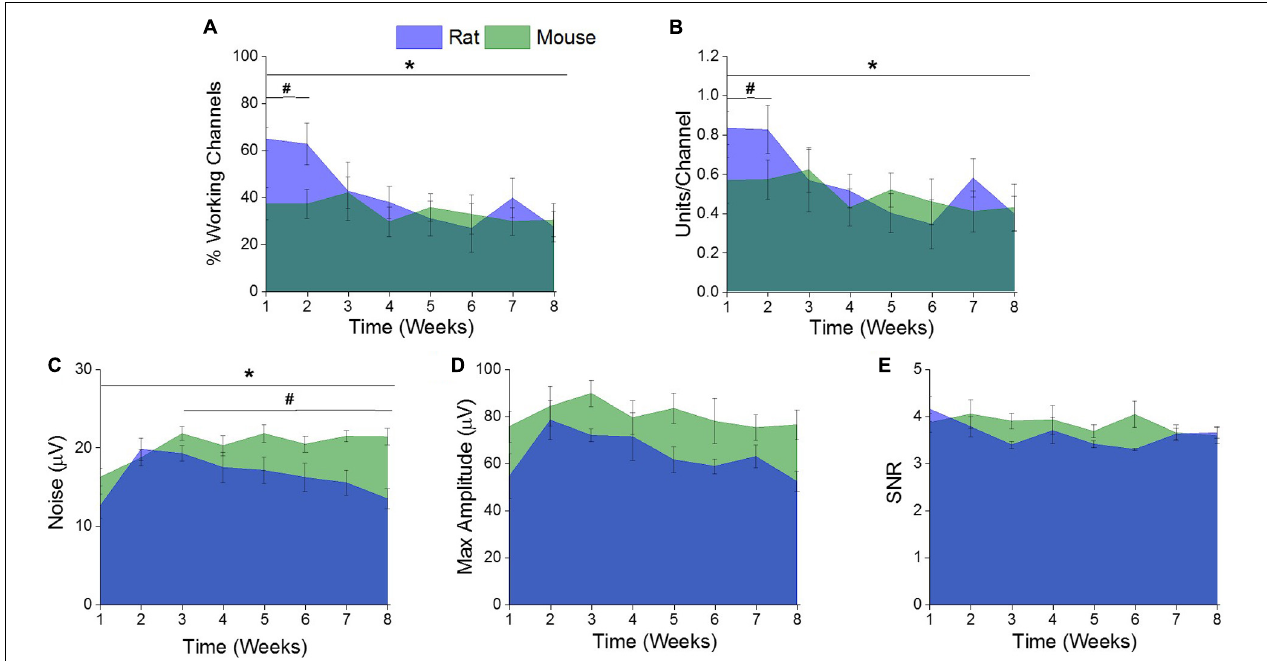
FIGURE 3 | Comparison of electrophysiological recording metrics between rat and mouse models. There were significant differences between the (A) % working channels and (B) units per channel between the rat and mouse recordings over the entire eight weeks. (* indicates a p < 0.05). Specifically, there were significantly more (A) % working channels and (B) units per channel recorded from the rat recordings compared to the mouse recordings at acute time points (1–2 weeks) (# indicates a p < 0.05). There were significant differences in (C) noise between the rat and mouse recordings over the entire eight weeks. (*indicates a p < 0.05). Specifically, there was significantly more noise from the mouse recordings compared to the rat between the acute (1–2 weeks) and chronic (3–8 weeks). (#indicates a p < 0.05). There were no significant differences between the recorded (D) maximum amplitude and (E) signal-to noise ratios (SNR) between the rat and mouse recordings over the entire eight weeks or when compared at acute versus chronic time